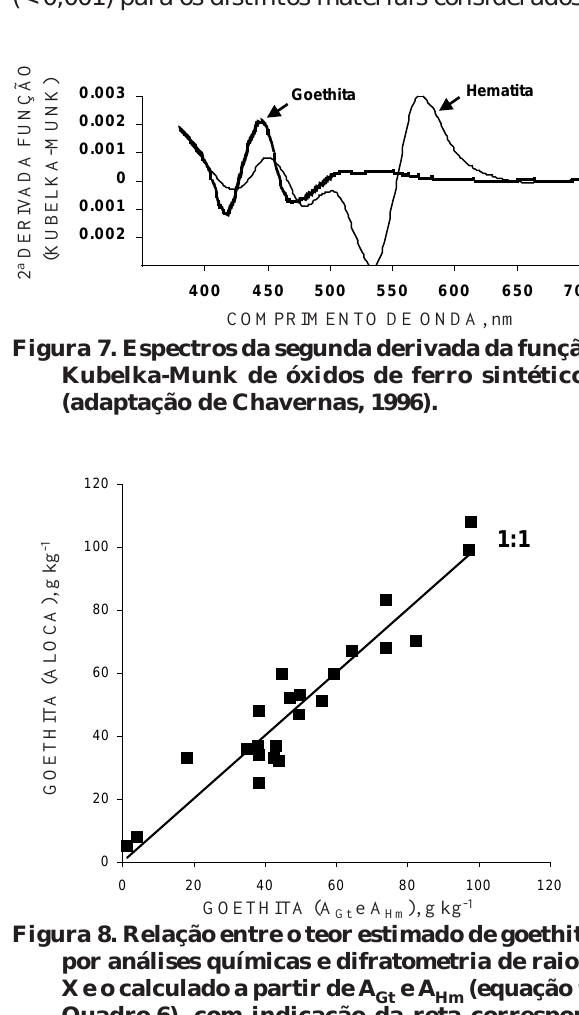
e A (equação 9, Gt Hm